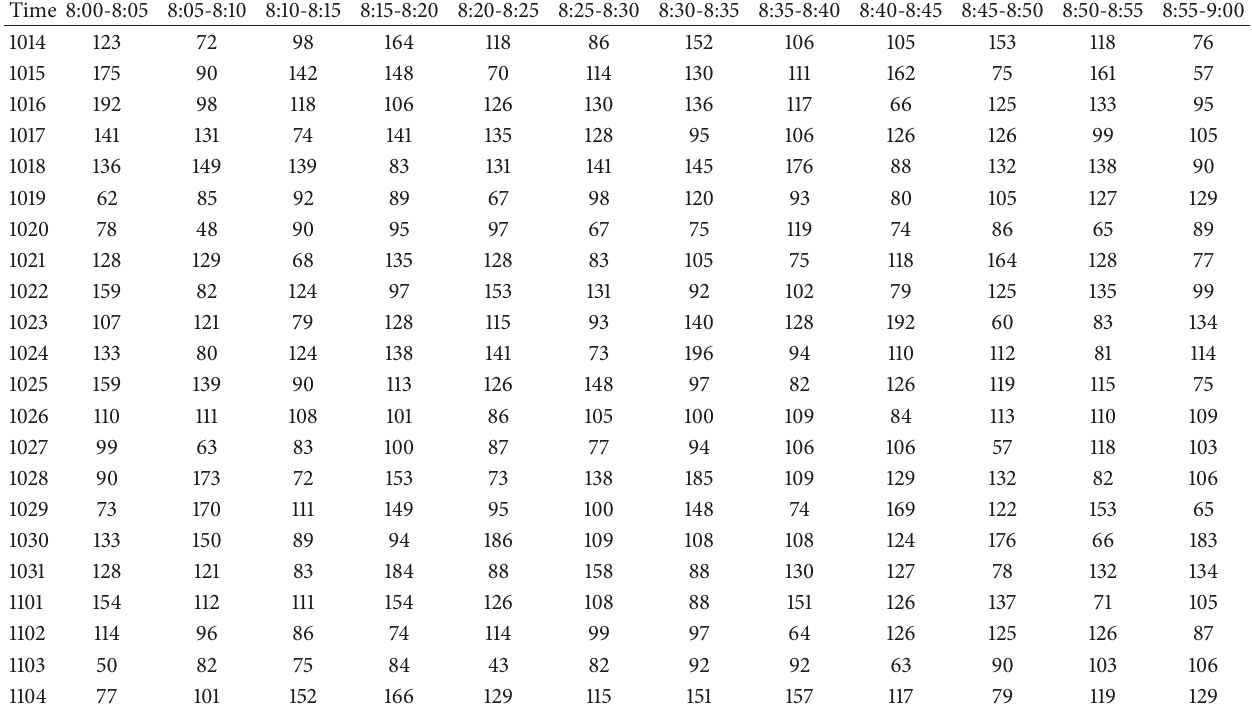
Table 2: Traffic flow data from 8:00 to 9:00 at a sampling interval of 5